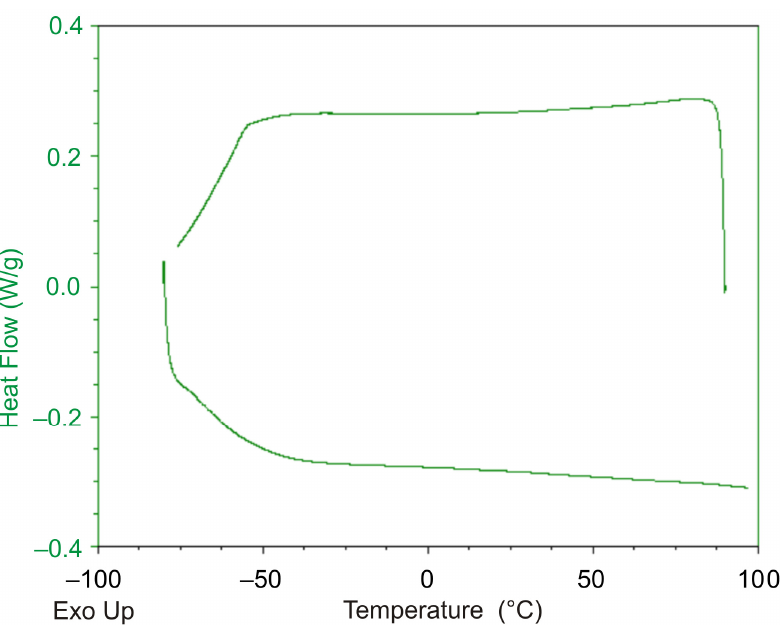
Figure 9. Dependence of heat flow on temperature recorded for DeSolite 3471-1-152A polymer by DSC TA Instruments Q2000.